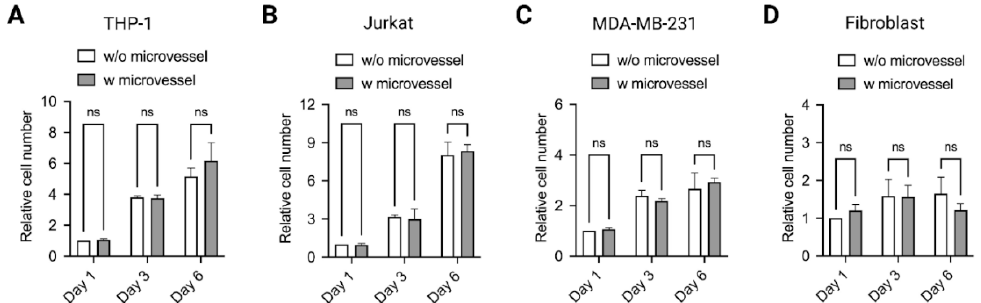
Figure 7. Cell proliferation within microvessel. Proliferation of ( A ) THP-1, ( B ) Jurkat, ( C ) MDA-MB-231 and ( D ) Fibroblast cells cultured for 6 days with and without microvessels. Data are presented as mean ± SD. Experiments were performed in at least 3 replicates. n.s. indicates non significant. * indicates a P value ≤ 0.05.